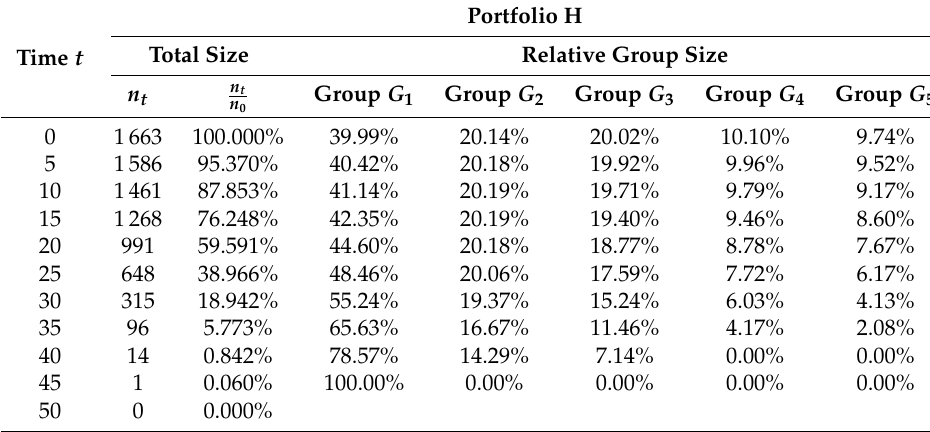
Table 20. Portfolio H: portfolio average benefit amount (additional amount with respect to the standard benefit for Portfolio